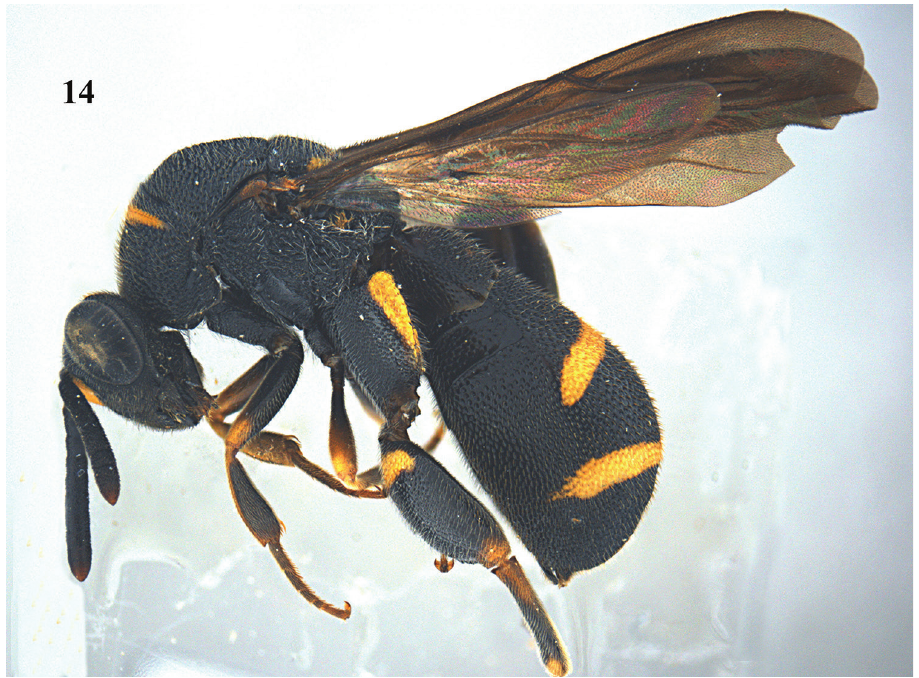
Figure 14. Leucospis japonica Walker, ♂ from Guangdong, Guangyinshan. Habitus lateral. Diagnosis. Body mainly black (Fig. 5), with exception of ventrally yellow antennal scape, pronotum with yellow transverse stripe anteriorly which sometimes is changed to three or six yellow spots, and yellow transverse stripe posteriorly which sometimes is triangular, mesoscutellum with pale yellow transverse band posteriorly, wings brown- ish, hind coxa pale yellow dorsally, hind femur with subbasal yellow lunate mark, from base crossing to dorsal border, T1 with a pair of large yellow spots laterad of oviposi- torial furrow, T5 with broad yellow band near posterior margin, epipygium with a pair of yellow small spots postero-laterally (Figs 5, 9); propodeum raised medially and emarginated posteriorly, median carina weak or absent; hind femur with twelve teeth ventrally, basal one largest (Fig. 13); hind tibia produced into a spine ventro-apically (Fig. 5); T1 with ovipositorial furrow (Fig. 9); ovipositor sheath at least reaching pos- terior margin of dorsellum (Figs 5, 8,